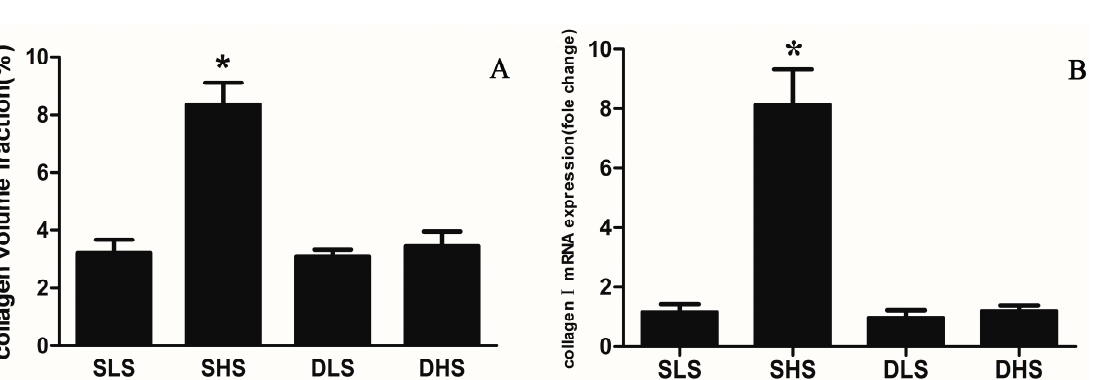
Figure 3. Changes in the expression of myocardial collagen I after high-salt intervention. ( A ) Changes in collagen volume fraction (CVF; %) in the four groups. * p < 0.01 vs. SLS; ( B ) Changes in mRNA for collagen I in the four groups. The mRNA expression was detected through real-time polymerase chain reaction (PCR) and normalized to the DLS group. * p < 0.01 vs.